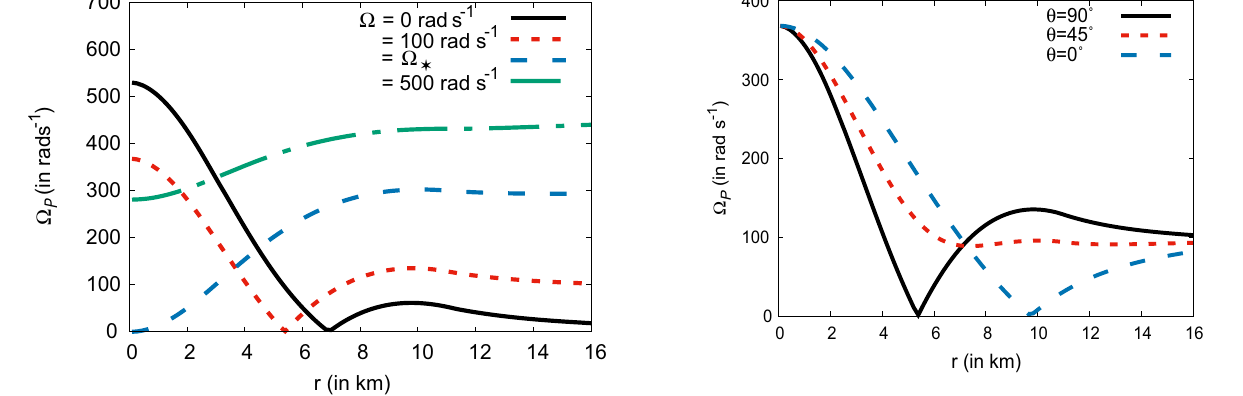
Fig. 11 LT precession frequency and overall precession rate along the equatorial plane around a 1 . 5 M 0 NS ( ω = 700 rad s − 1 ) of radius 11 km with varying the orbital angular velocity of the gyro. The black solid curve denotes the LT precession rate (magnitude of Ω P with Ω = 0), the red short dashed curve, blue dashed curve and the green dot dashed curve denote overall precession rate for Ω = 100 rad s − 1 , Ω ∗ and 500 rad s − 1 respectively